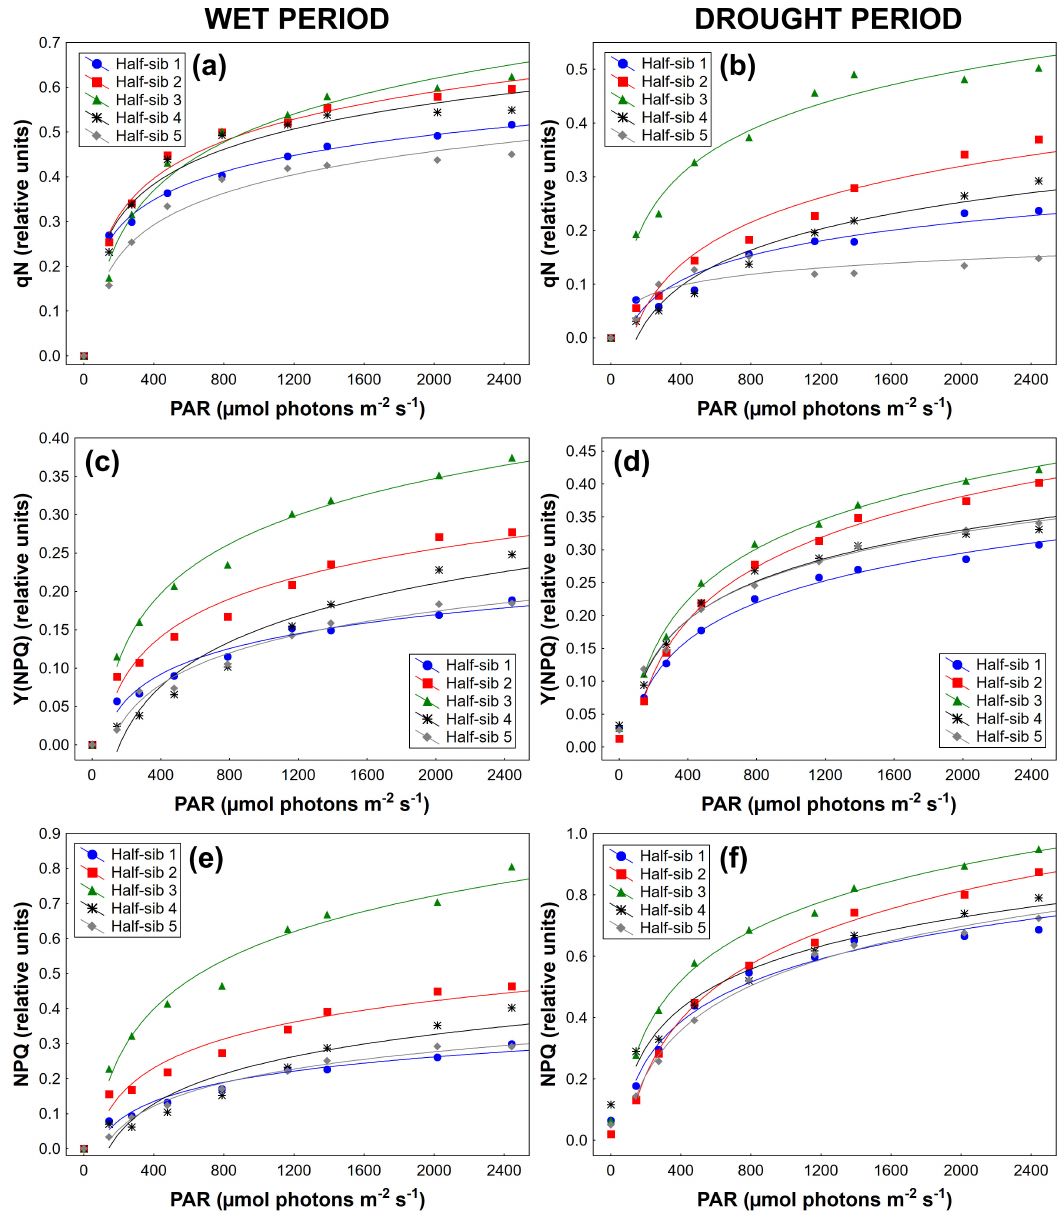
Figure 6. Chlorophyll a fluorescence parameters generated by RLC’s as a function of photosynthetically active radiation (PAR, µ mol photons m − 2 s − 1 ) applied to leaves of five Q. robur half-sib lines during wet and drought periods. ( a , b ) Coe ffi cient of non-photochemical quenching (qN, relative units), ( c , d ) quantum yield of regulated energy dissipation (Y(NPQ), relative units), ( e , f ) Stern-Volmer type non-photochemical fluorescence quenching (NPQ, relative